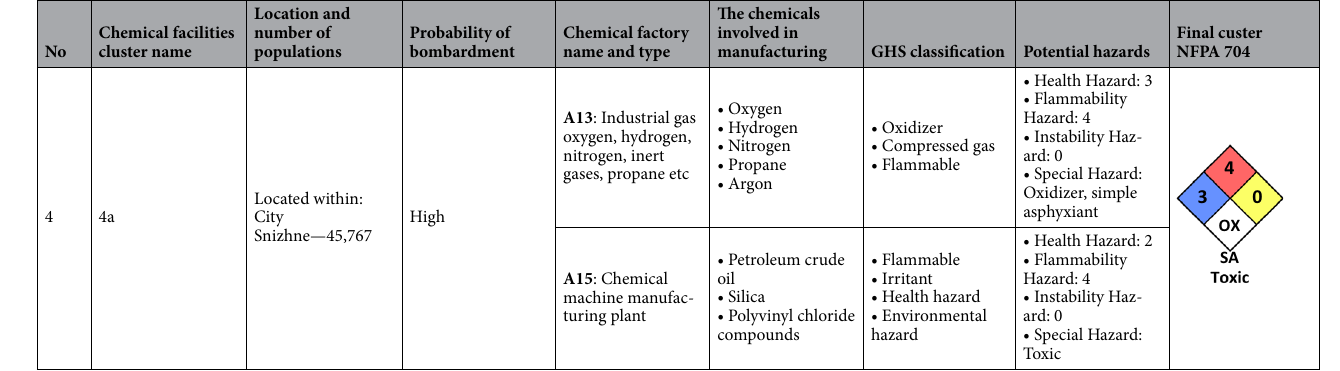
Table 2. Chemical facilities cluster analysis table for Donetsk Oblast.